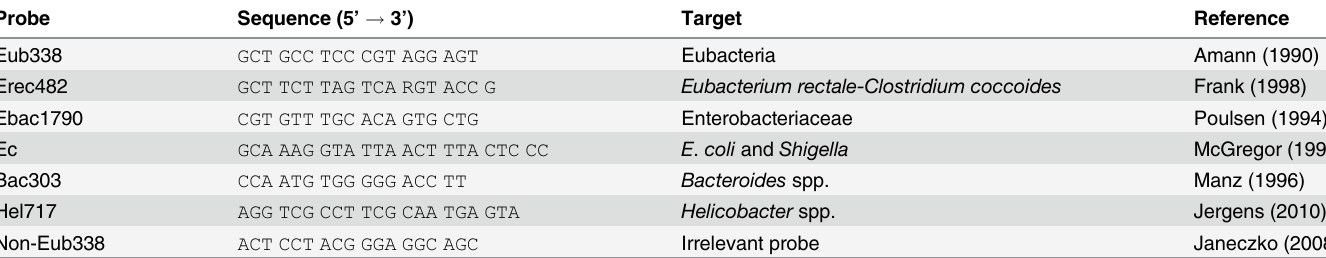
Table 1. Probes used for fluorescence in situ hybridization. Probes used for in situ bacterial